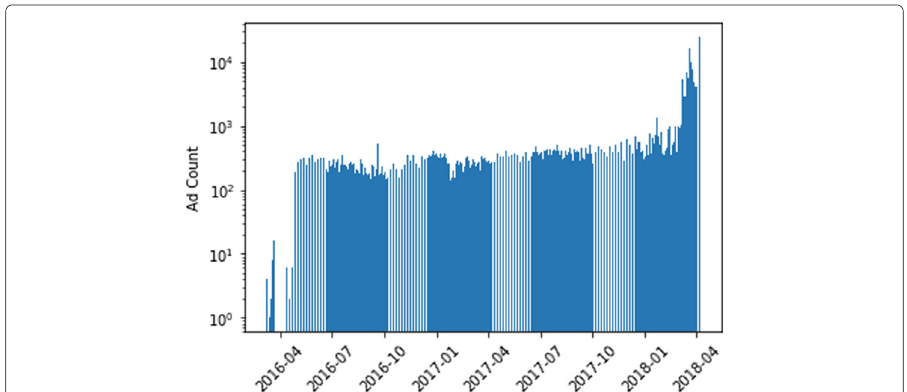
Fig. 2 A distribution of number of ads over time in the dataset used in this study. The activity we are profiling in this article has all occurred over a maximal period of three